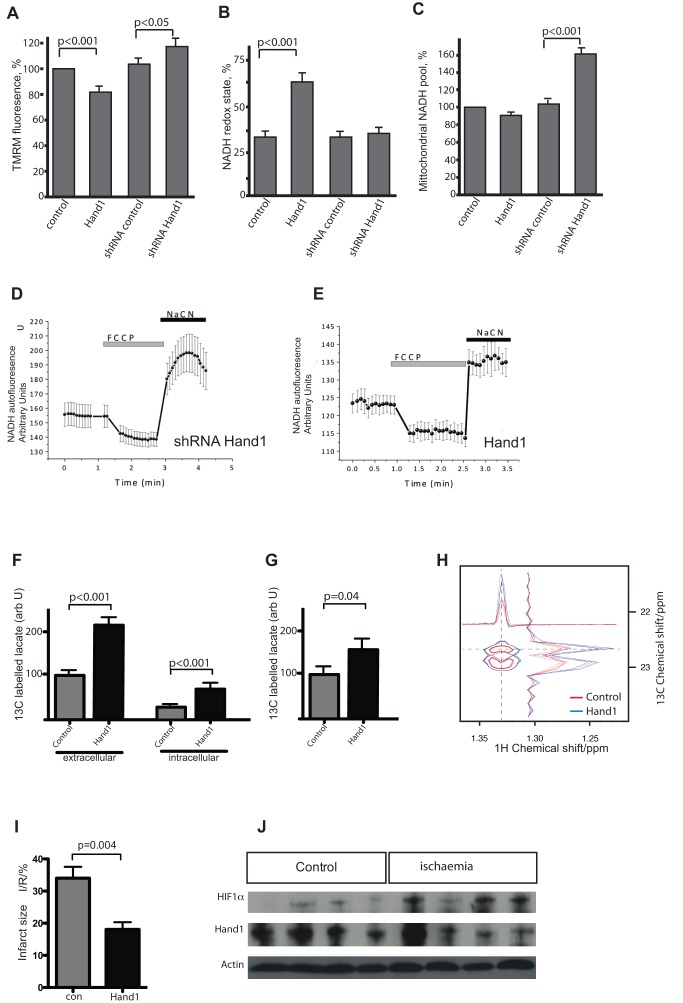
Hand1 levels control mitochondrial function, metabolic flux, and ischaemia susceptibility in cardiomyocytes.(A) TMRM fluorescence measured in stably transfected HL1 cell lines, showing significantly reduced mitochondrial inner membrane potential in Hand1 up-regulation, and significantly increased potential in shRNA-expressing lines knocking down Hand1 expression (number of cells analysed = 26, 34, 23, and 23, respectively) (p = two-tailed t test). (B) Significantly increased NADH redox state in Hand1 expressing stable HL1 lines, measured by NADH autofluoresence. (C) Hand1 up-regulating stably transfected HL1 cells display a significantly reduced mitochondrial NADH pool compared with controls, whereas knockdown of Hand1 results in an increase in the NADH pool, estimated as a difference in fluorescence (arbitrary U) between responses to FCCP and NaCN. (D) Example of an NADH autofluoresence trace of a stably transfected Hand1 shRNA HL1 cell, showing maximally oxidized state in response to the uncoupler FCCP, and minimally oxidized state in response to sodium cyanide, in comparison to the trace for Hand1 transfected cell. (E) A typical NADH autofluoresence trace of a stably transfected Hand1 line, showing much lower NADH levels, as defined by the ratio of maximally and minimally oxidized states. (F) 13C labeling of lactate is increased in supernatant (extracellular) and cell extract (intracellular) of stably transfected Hand1 up-regulating HL1 cells after labeling of cells with uniformly labeled 13C glucose (n = 4 for each measurement), measured by 1H. (G) Increased detection of 13C labeling of lactate in adult XMLC-Hand1 mice 1 h after administration of uniformly labeled 13C glucose (n = 6 each group, p = 0.04, two-tailed t test). (H) 1H NMR showing increased 13C incorporation into lactate from [U 13C6]-glucose in Hand1 up-regulating HL1 cells (blue trace) compared to controls (red trace). (I) Following Langendorff perfusion and 35 min of global ischaemia followed by 30 min of reperfusion, hearts from 2-mo-old Hand1 up-regulating XMLCrTTA::tetHand1 adult mice following 1 mo of doxycycline induction exhibit a 47% reduction in infarct size, infarcted tissue area expressed as a proportion of total at-risk tissue area (I/R) (n = 6, p = 0.004, two-tailed t test). (J) Western blot of protein extracts of wild-type adult Langendorff perfused hearts following 30 min of global ischaemia. Increased levels of HIF1α are detected following global ischaemia, but no difference in Hand1 protein levels is apparent.